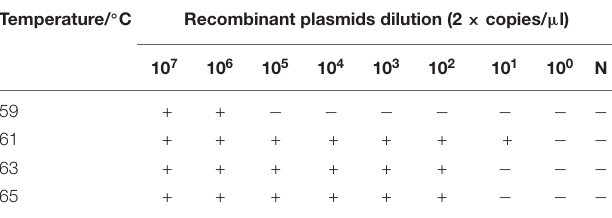
TABLE 6 | Reaction temperature optimization of RNA for RT-LAMP-VF